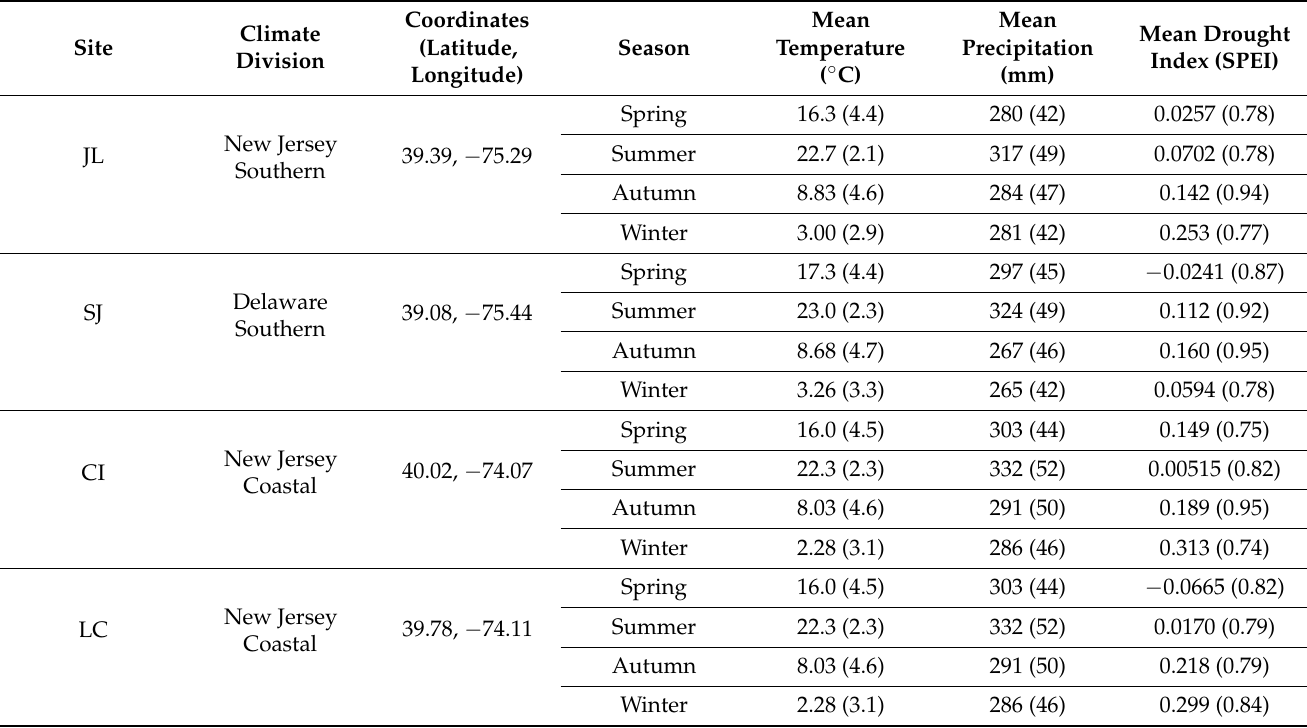
Table 1. Description and means of seasonal climatic variables from 1980–2019. Temperature and precipitation data were derived from NOAA’s NCEI database, whereas drought index (SPEI) were sourced from the Climate Engine. Standard deviations are in parenthesis. Seasons are the mean (temperature, drought) or sum (precipitation) of three-month